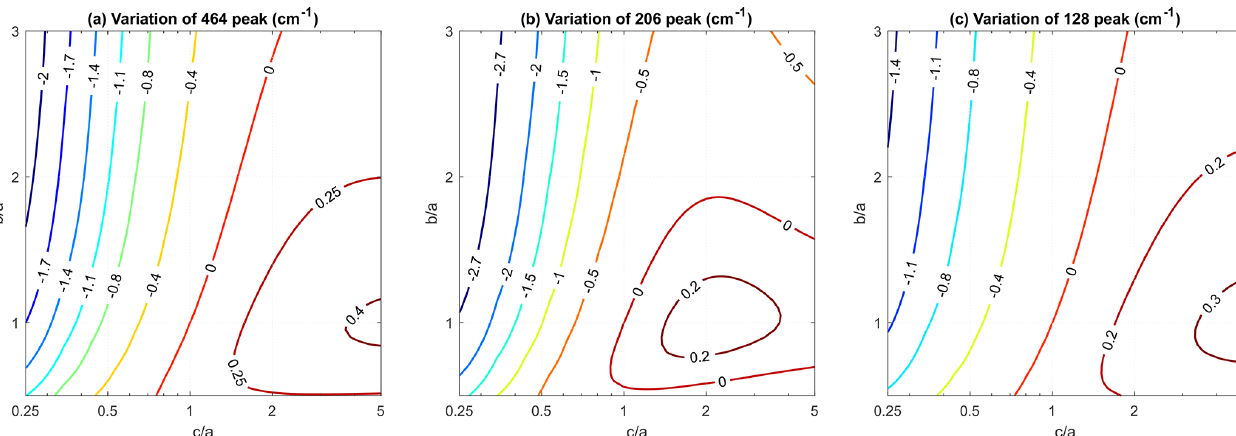
Figure 4. The effect of geometrical aspect ratio of ellipsoidal quartz inclusion for c/a axes and b/a axes on Raman wavenumber shift entrapped in garnet host. The contours show the variation of wavenumber shift compared to perfectly spherical quartz inclusion ( c/a = 1, b/a = 1). The initial residual inclusion pressure is assumed to be hydrostatic 1GPa for the reference spherical inclusion. The wavenumber shift variations are due to changing the geometrical aspect ratios of c/a and b/a axes. The Raman shifts are calculated using the residual strain and the Grüneisen tensor in Murri et al. (2018). For c/a> 1 the inclusion is prolate, and for c/a< 1 the inclusion is oblate. The stiffness tensor of quartz at room P – T is from Heyliger et al. (2003) and that for almandine garnet is from Milani et al.